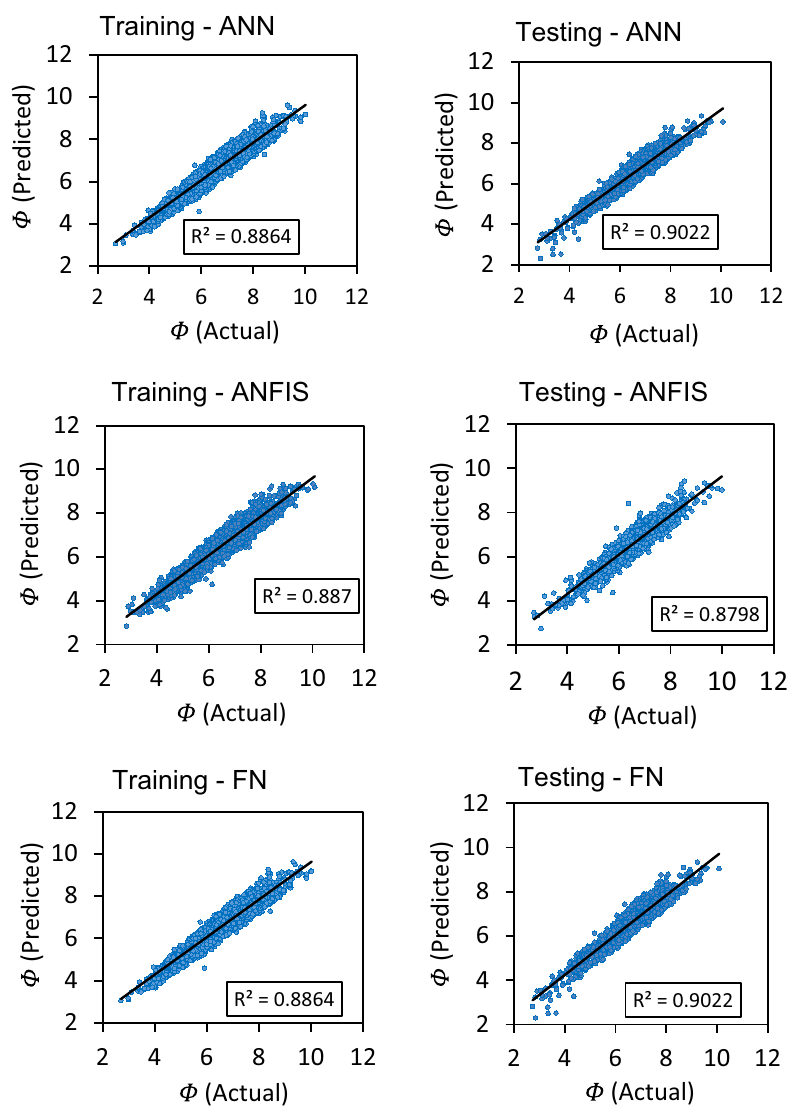
Figure 9. Cross-plots between the predicted and actual Φ NMR values for training and testing dataset of ANN, ANFIS and FN